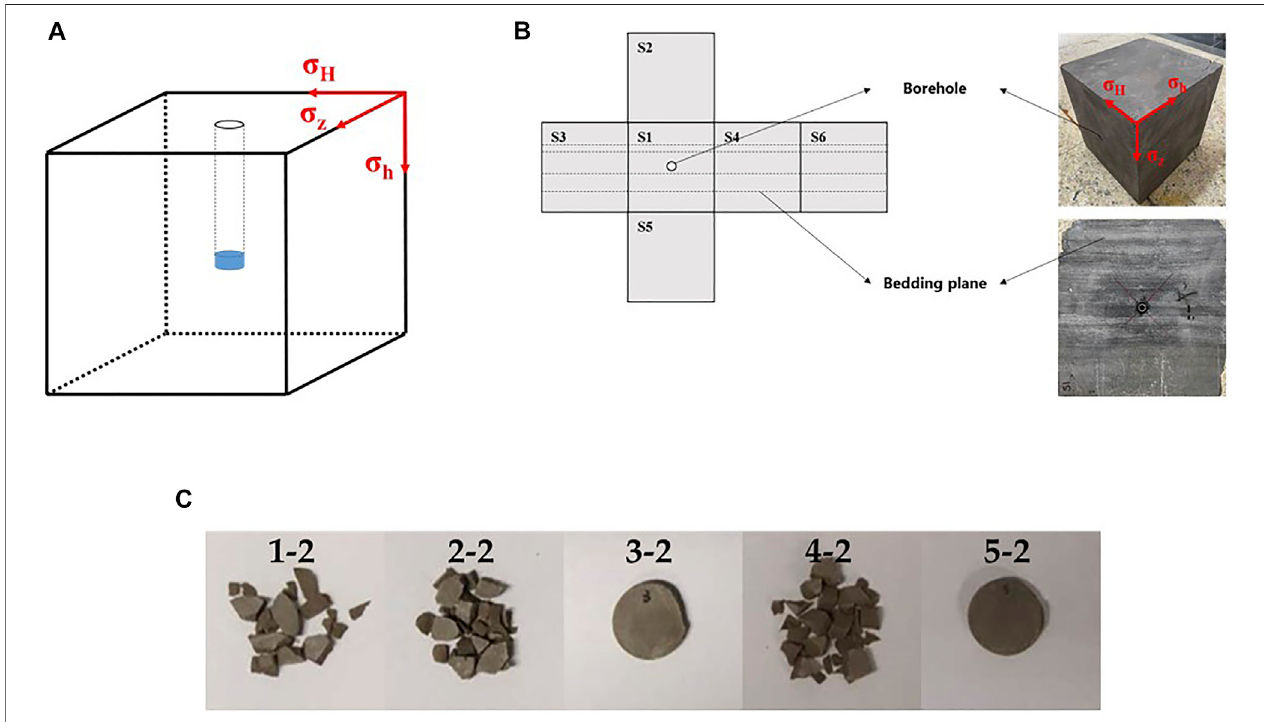
FIGURE 2 | The specimens for fracturing experiments and soaking experiments. (A) Sketch of the thin interbedded specimen; (B) Display ofthin interbedding and six surfaces (C) The specimens for soaking experiments.